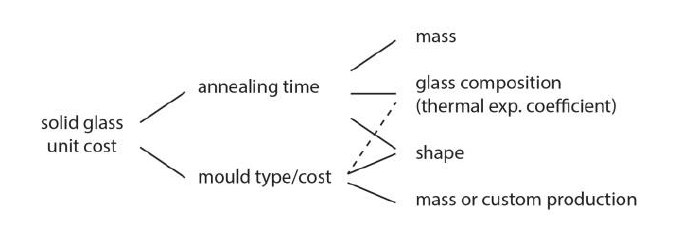
Fig. 2 Rough scheme indicating the main factors influencing the manufacturing cost of a solid cast glass component. It should be noted that the effect of the glass composition is not investigated in this study.